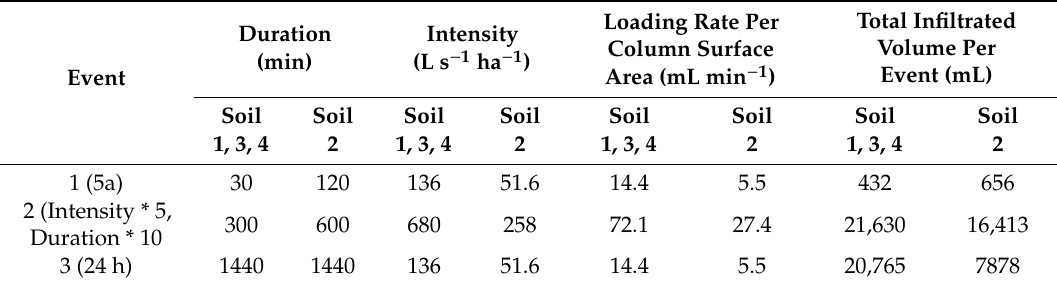
Table 4. Precipitation duration (min) and intensities as well as loading rate per soil surface area and total infiltrated volume for the 3 simulated